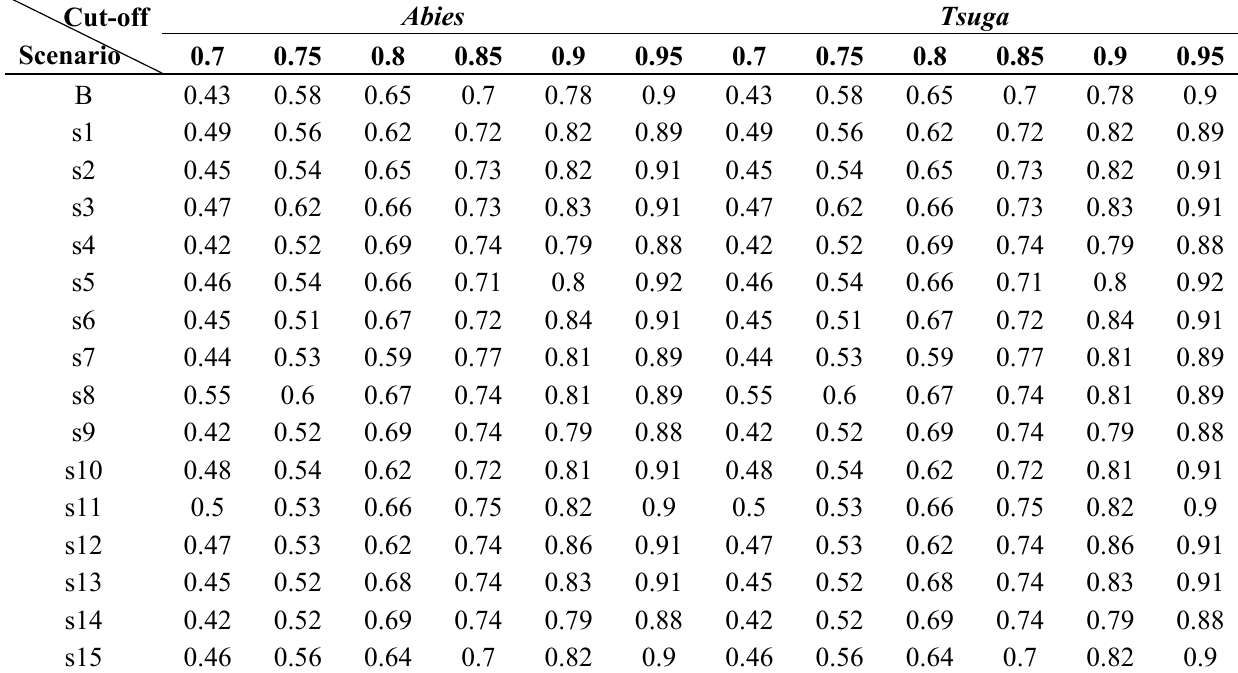
Table 3. The global uncertainty under baseline and 15 future scenarios.